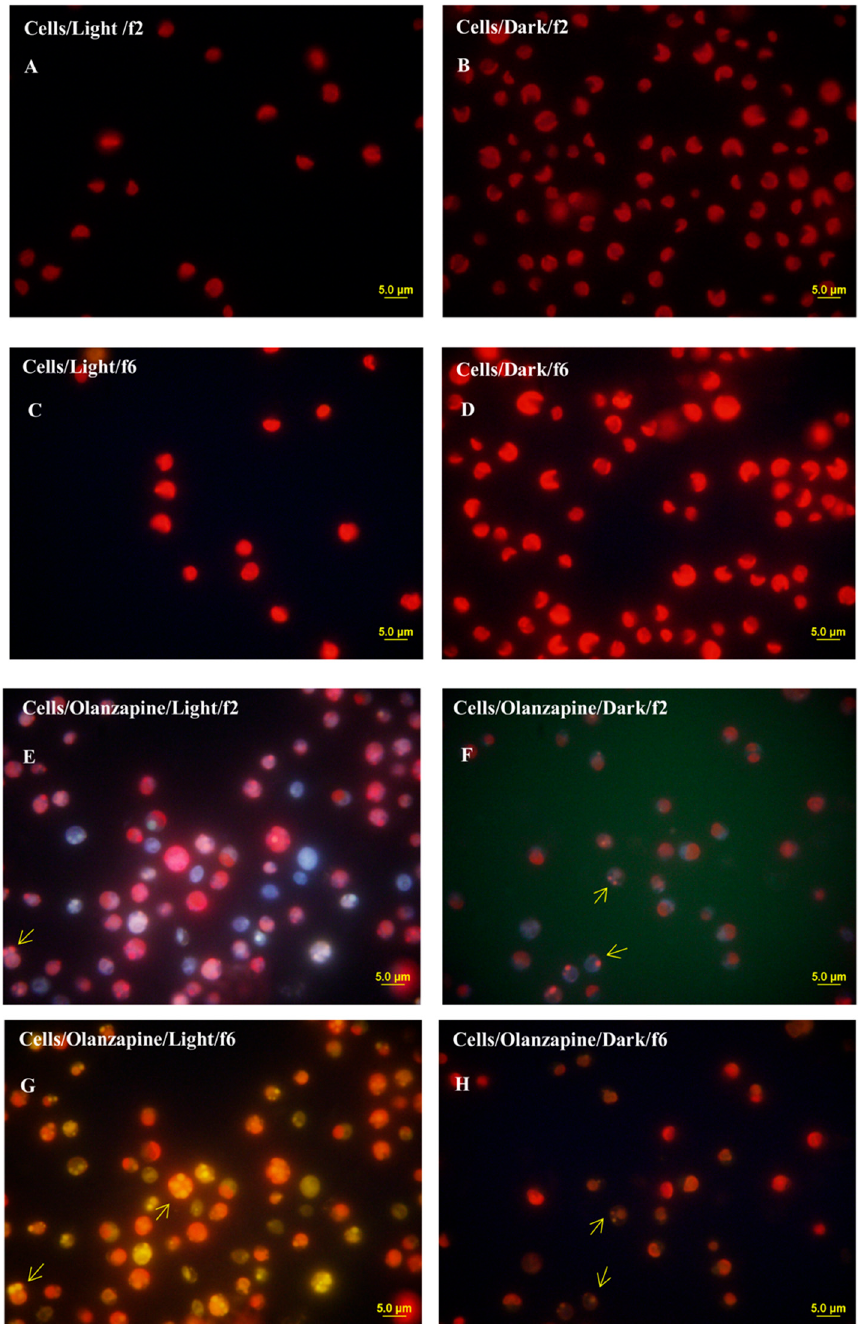
Figure 4. Epifluorescence microscopy images of Nannochloropsis sp. cells showing the red autofluorescence of chlorophyll from chloroplasts and fluorescence of the olanzapine. Cells grown in an f/2 medium (no pharmaceuticals added to the medium) ( A – D ). ( A ) and ( C ) show cells grown autotrophically. ( B ) and ( D ) show cells grown in the dark (different microscope filters, f2 and f6). Cells grown in f/2 medium with OLA added to the medium ( E – H ). ( E ) and ( G ) cells grown autotrophically (microscopy filters f2 and f6). ( F ) and ( H ) cells grown in the dark (microscopy filters f2 and f6). 3.3. Population Density Cultures of Nannochloropsis sp. immobilized in PVA beads grew from 1.9 × 10 7 cells mL − 1 to 2.4 × 10 7 cells mL − 1 in the first 12 h and remained stable, with a slight decrease after 60 h of culture, 2.2 × 10 7 cells mL − 1 (Figure 5). Cultures of Nannochloropsis sp. immobilized in PVA and grown in the presence